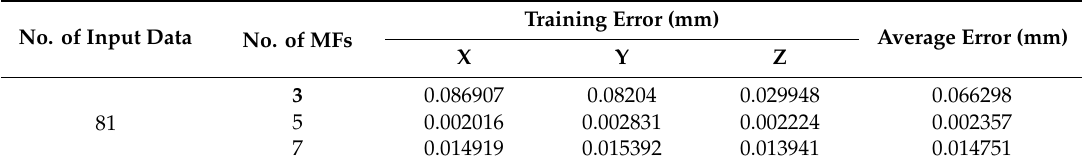
Figure 11. Target feature extraction and pose estimation process: ( a ) Color image taken by the left camera, ( b ) Color image taken by the right camera, ( c ) Image of the left camera on the HSV space, ( d ) Image of the right camera on the HSV space, ( e ) Filtered image of the left camera, ( f ) Filtered image of the right camera, ( g ) Object pose estimation on the left camera, and ( h ) Object pose estimation on the right camera.